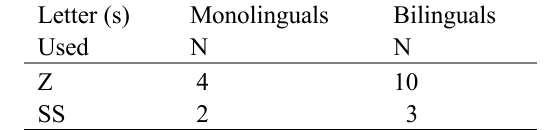
Table 9. Misspellings for the phoneme /z/ in